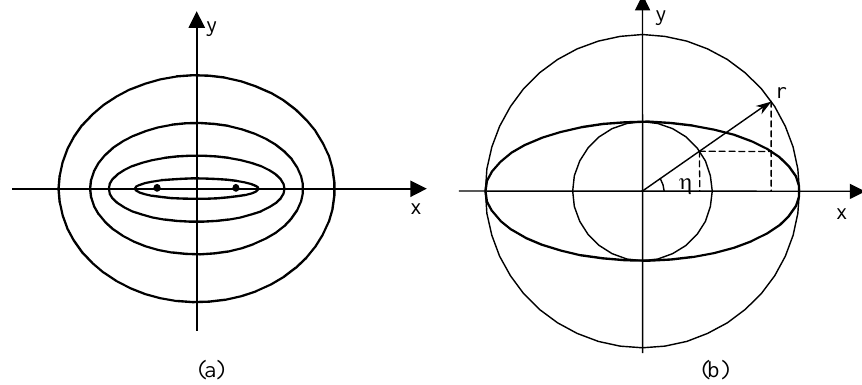
Figura 2: (a) famiglia di ellissi con gli stessi fuochi; (b) costruzione parametrica